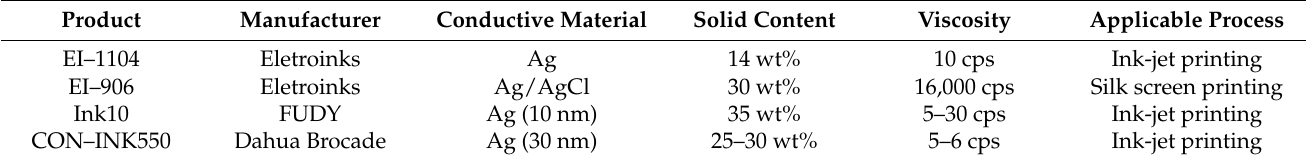
Table 8. Conductive ink